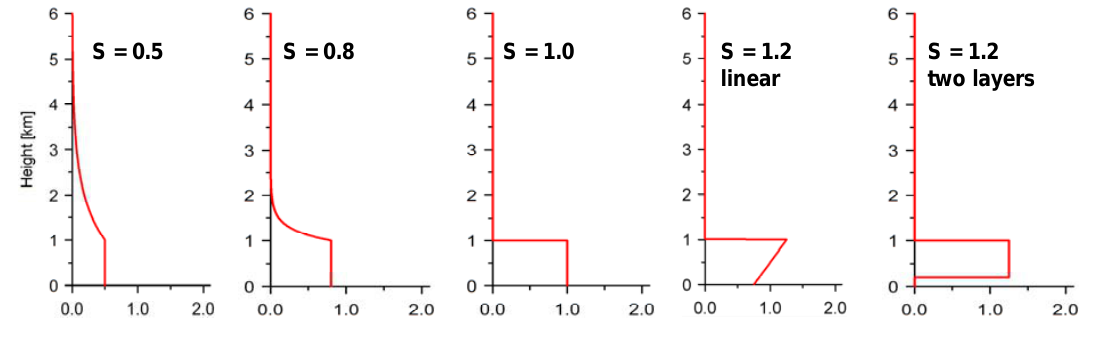
Fig. 2 Parameterisation of (relative) profile shapes used in this study. The layer height parameter L is set to 1km for all profiles. Also the vertically integrated profiles have the same value (1 artificial unit describing either AOD or trace gas VCD). For a shape parameter S =1, a “box”-profile is obtained with zero values above L . For S < 1, part of the aerosol or trace gas amount is located at altitudes > L with an exponential decrease; Shape parameters S > 1 describe elevated layers. In this study we investigate two profile parameterisations for elevated layers: linear increasing profiles or profiles with two layers (see text).